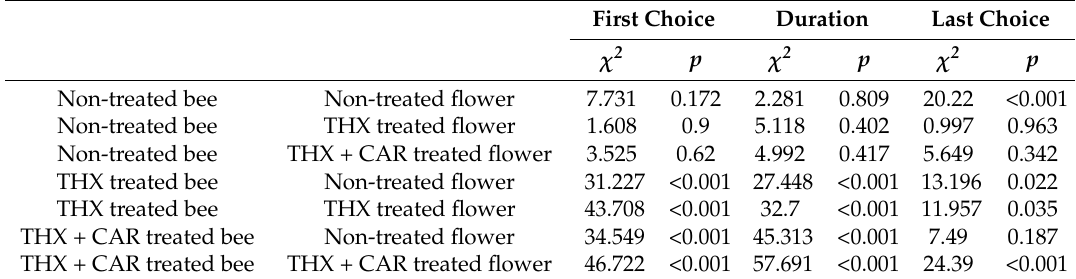
Table 1. The statistical results of agrochemicals effect on orientation